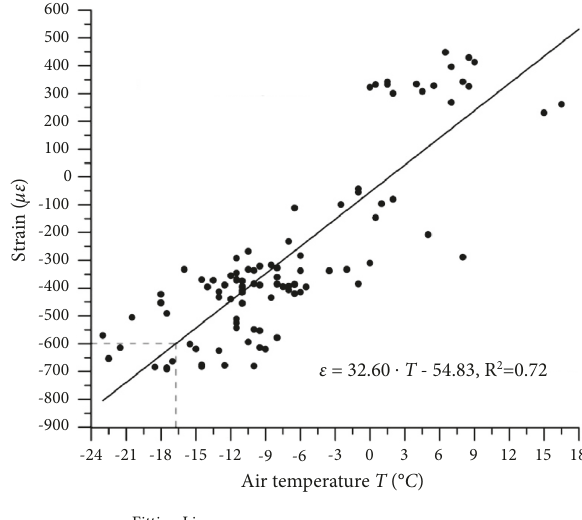
Figure 13: Relationship between the average strain of the F4 layer soil of the roadbed and the air temperature.